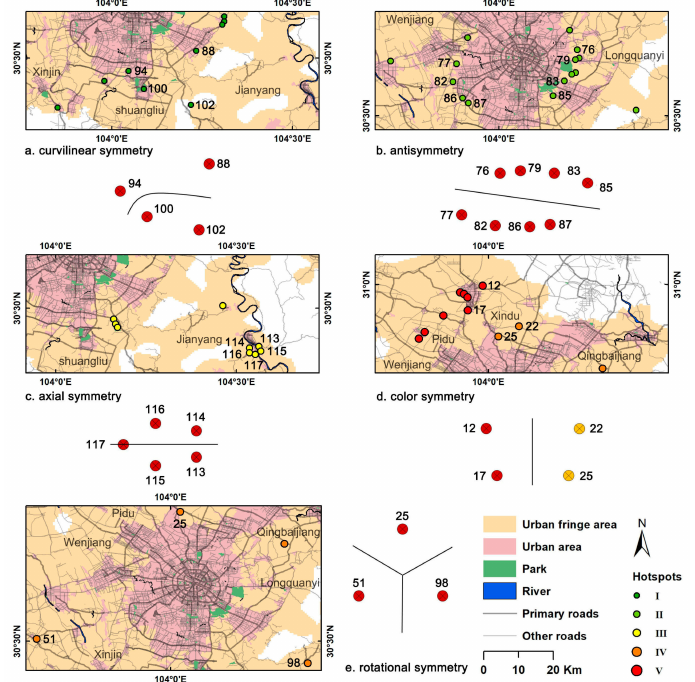
Figure 15. Extraction results of the generalized symmetric structure Tupu for hotspots (UFAs of